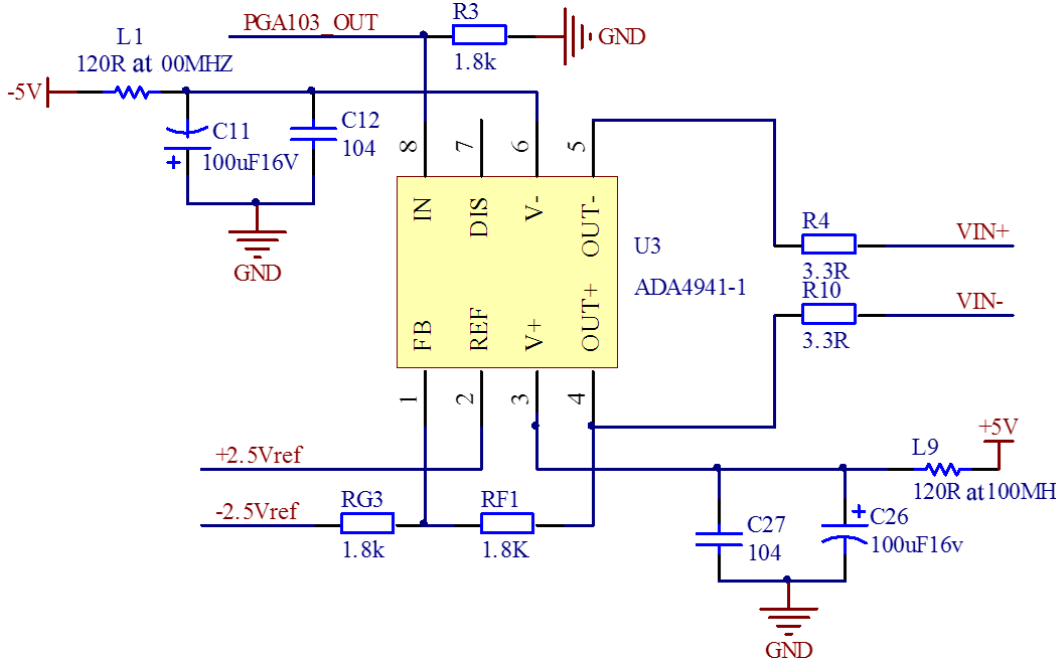
Figure 5. Single-ended-to-differential converter circuit.